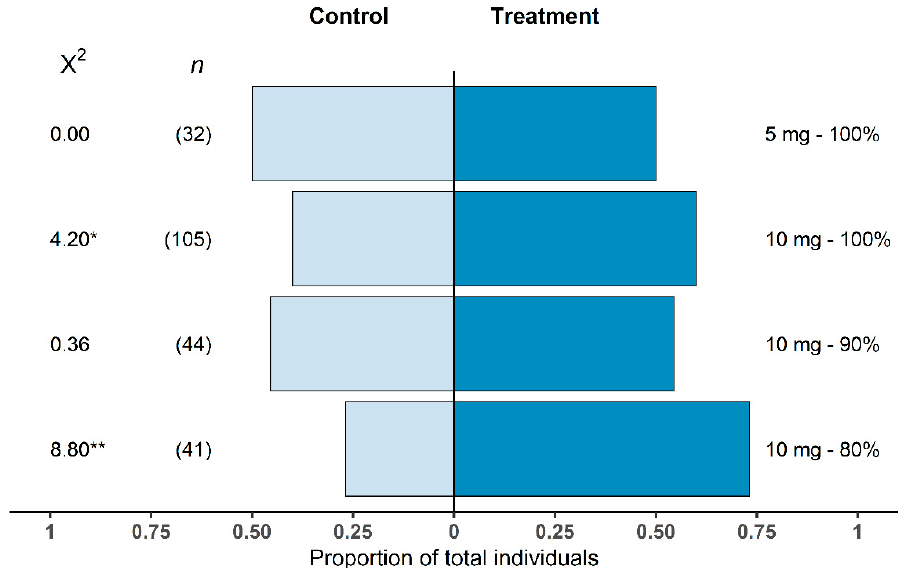
Figure 3. Proportional response of Trissolcus japonicus female adults that chose a kairomone lure treatment or control ( n = 32–105) within the 30 min experimental period. Chi-squared values are presented and numbers in parentheses represent sample size; * p < 0.05; ** p < 0.01.